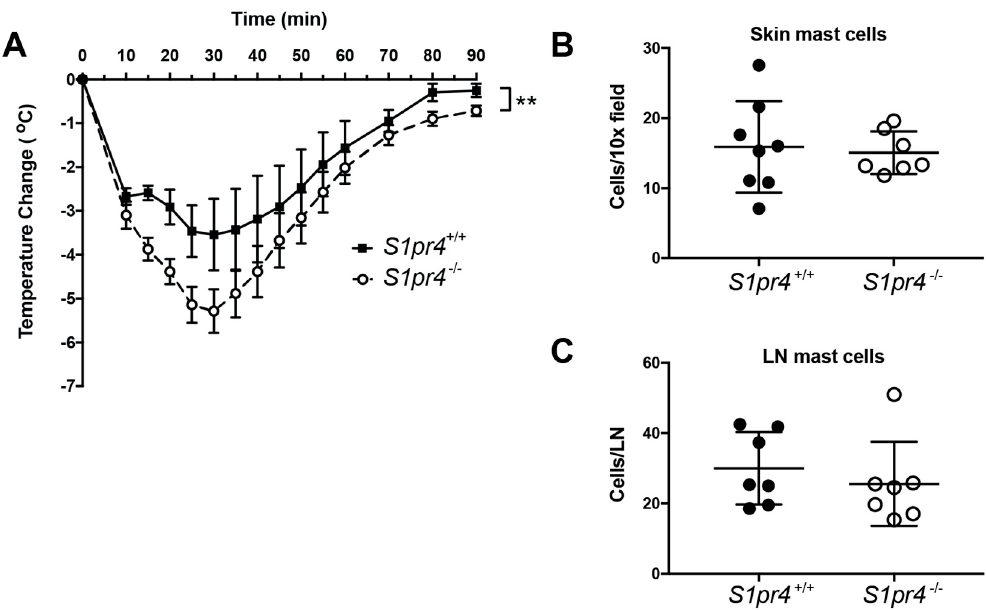
Figure 4. S1pr4 deletion exacerbates PSA. ( A ) S1pr4 +/+ and S1pr4 − / − mice were injected i.v. with 3 µg of mouse IgE. 24 h later, systemic anaphylaxis was induced by i.v. injection of 9 µg of anti-mouse IgE. Body temperature was monitored at the indicated times (S1pr4 +/+ n = 4, S1pr4 − / − n = 7). The asterisks between the curves indicate significant differences ( p < 0.001) between genotypes using a two way-ANOVA test. ( B , C ) Dorsal skin biopsies ( B ) and inguinal lymph nodes (LN) ( C ) harvested from S1pr4 +/+ and S1pr4 − / − mice were fixed in 10% neutral buffer formalin, embedded in paraffin and sectioned. Three sections per skin biopsy and two sections per lymph node were stained with toluidine blue and eosin. Each dot represents the average number of metachromatic staining cells/10 × field ( B ) or inguinal LN section ( C ) in one mouse and was calculated from five fields for each section examined, averaging values from 3 ( B ) or 2 ( C ) different sections for each tissue/animal. Floating bars represent the mean ± SE for each group of mice.